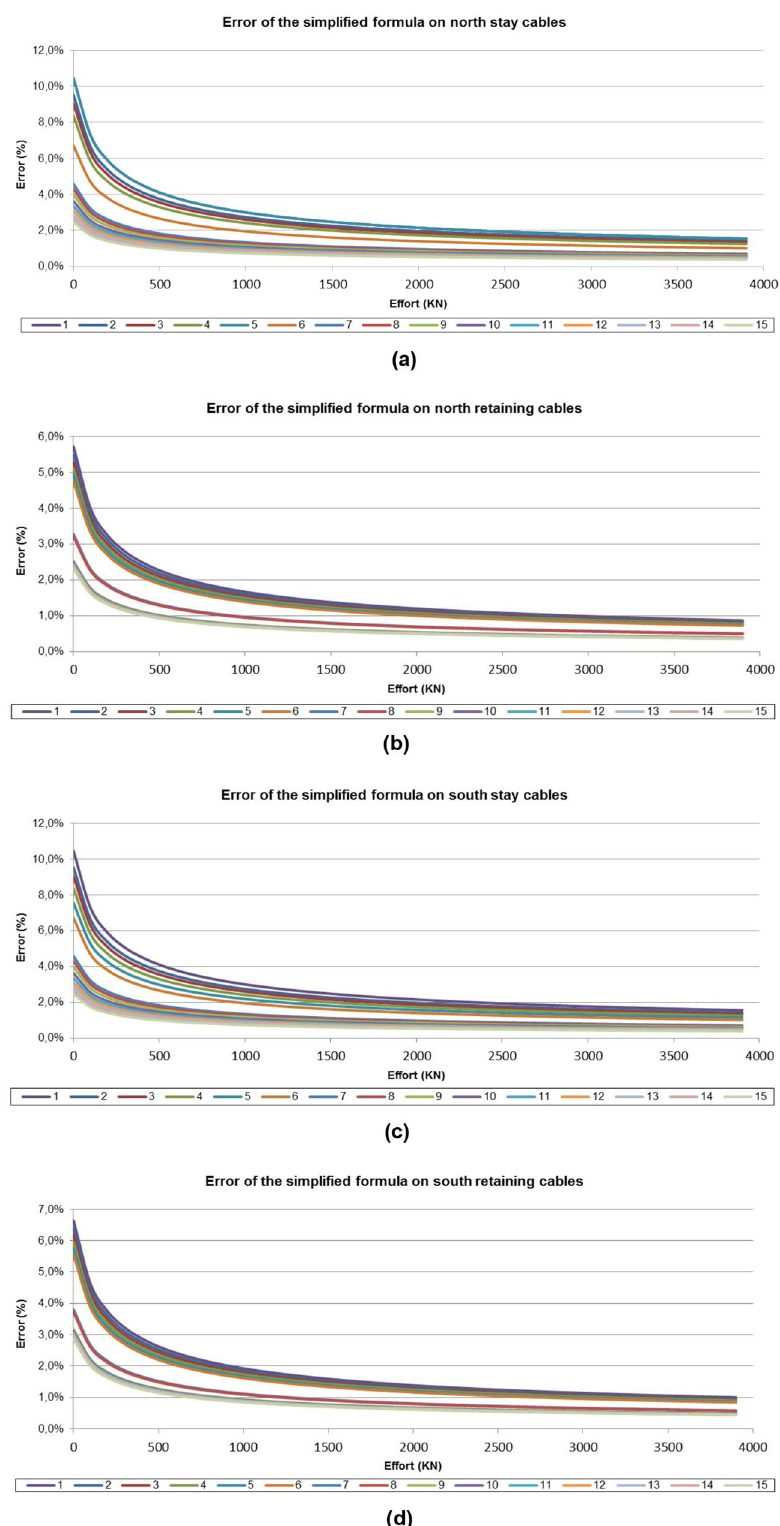
Figure 9. Evolution of the error committed by the simplified formulation of the vibrating wire: ( a ) north suspension cables; ( b ) north retaining cables; ( c ) south suspension cables; ( d ) south retaining